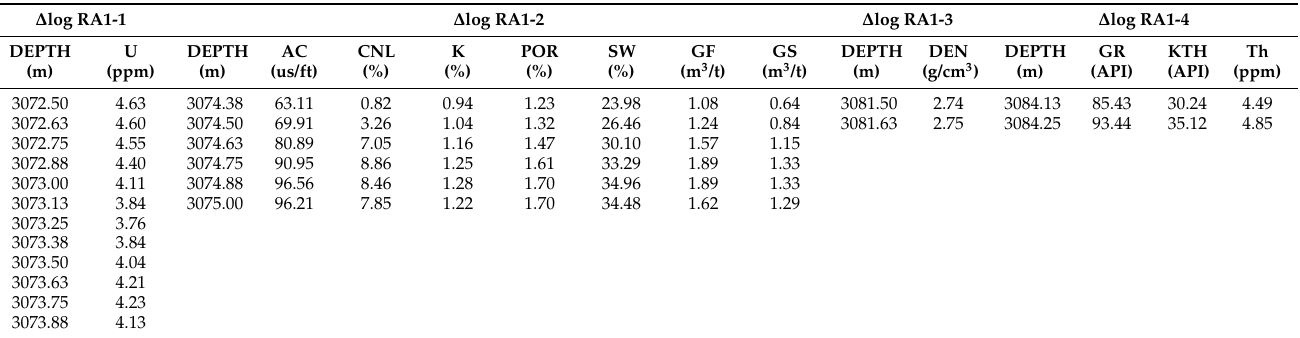
The average reservoir parameters corresponding to 8 ∆ log R in C1 well are analyzed (Figure 7, Table 12). The units of each parameters: RD (1~1000 ohm.m), AC (150~0 us/ft), GR (0~150 API), KTH (0~150 API), CNL (45~ − 15%), DEN (1.95~2.95 g/cm 3 ), K (0~5%), Th (0~20 ppm), U (0~10 ppm), POR (0~20%), SW (0~100%), GF (0~10 m 3 /t), and GS (0~50 m 3 /t). Among them, in the depth corresponding to ∆ log RC1-3, the average val- ues of GR, CNL, U, POR, GF (free gas), and GS (adsorbed gas) are the highest. In the depth corresponding to ∆ log RC1-4, the average value of SW is the highest. In the depth corresponding to ∆ log RC1-5, the average value of DEN is the highest. In the depth corre- sponding to ∆ log RC1-7, the average values of KTH, AC, K, and Th are the highest. The range values and average values of relevant reservoir parameters are show in Figure 7. The Ro of C1 well is between 1.86 and 2.67%, the maturity is not high, and the variation range of resistivity curve is small in these 8 ∆ log